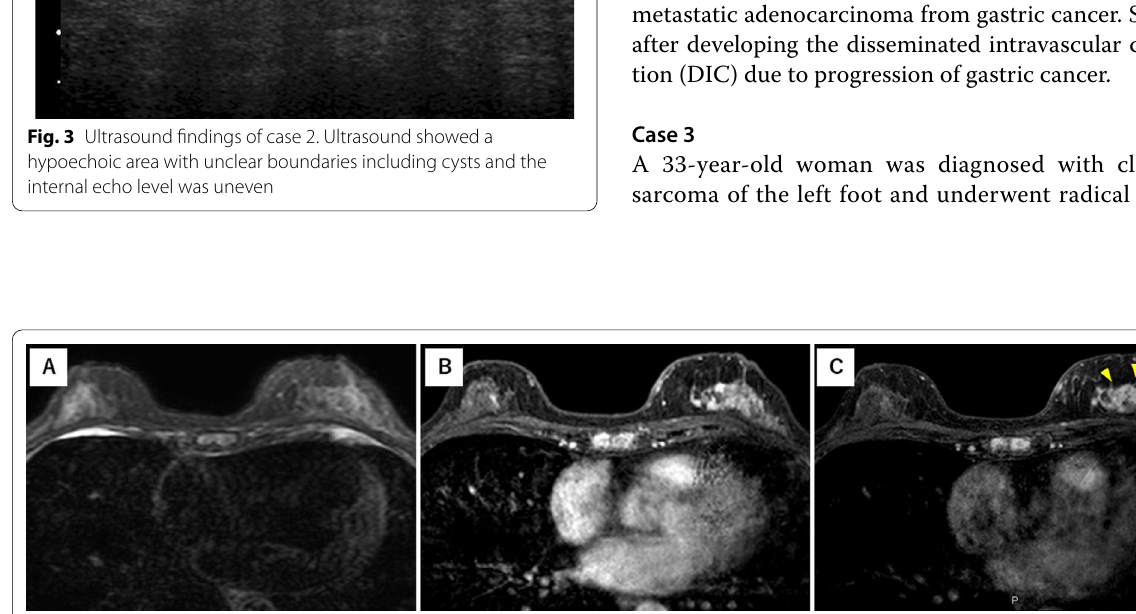
Fig. 4 Findings of contrast-enhanced magnetic resonance. Contrast-enhanced MRI showed early enhancement of non-mass lesion in the upper-outer region of the left breast. a T2-weighted, b T1-turbo field echo (TFE) and c High-resolution (HR) images. TFE ( b ) and HR ( c ) images indicated abundant blood flow and early enhancement within the non-mass lesion (yellow arrowheads),